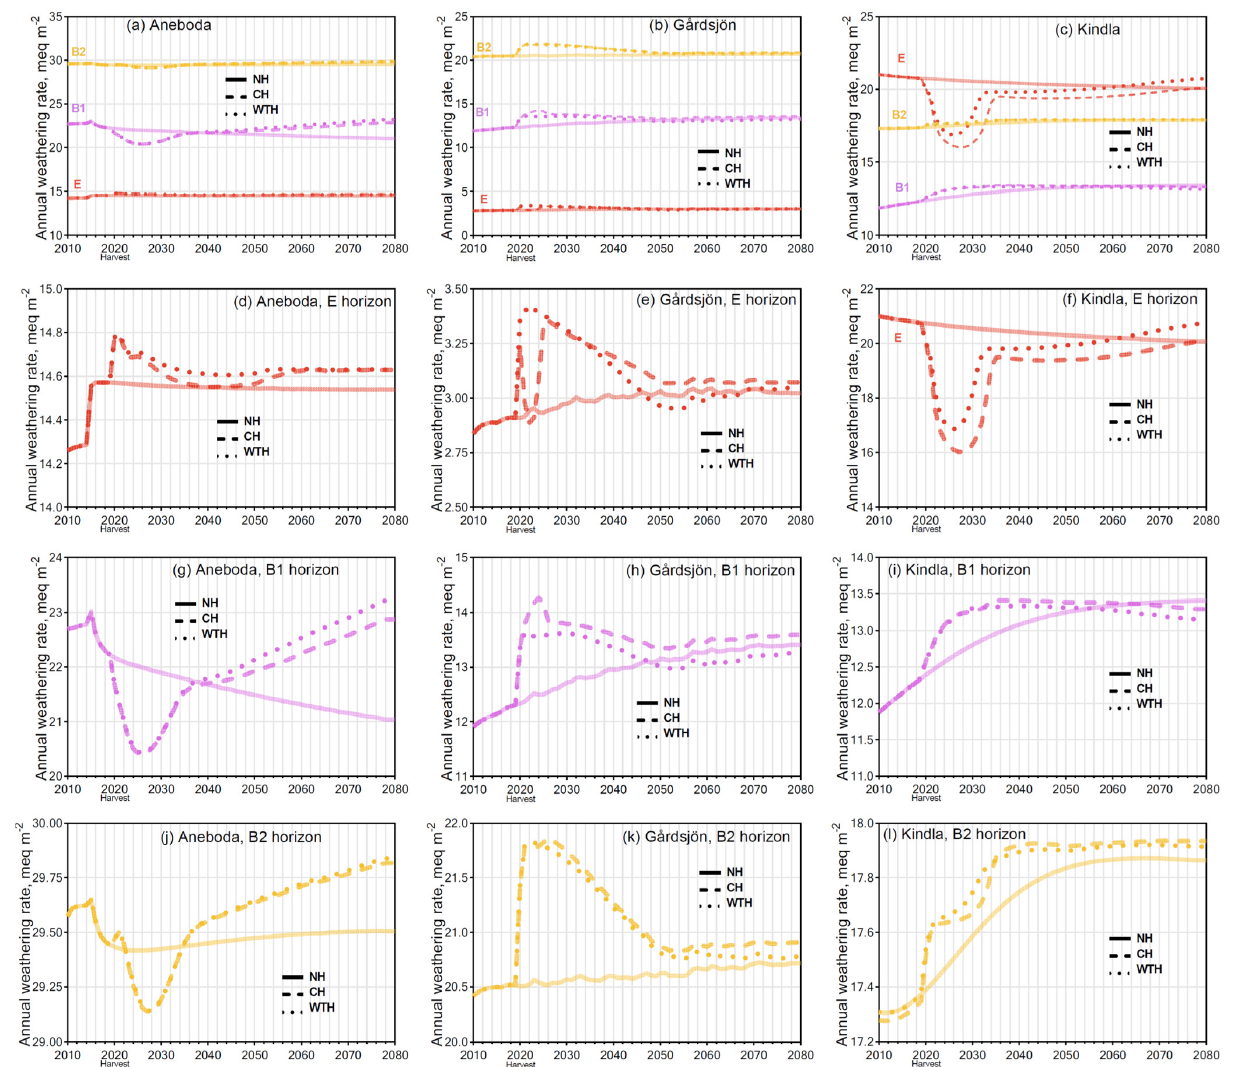
Figure 5. Simulated effects on base cation weathering rates in the conventional harvest (CH), whole-tree harvest (WTH), and NH scenarios. The time series starts in 2010 just before harvest and the graphs are scaled in order to demonstrate differences between harvest intensities at the different sites and soil